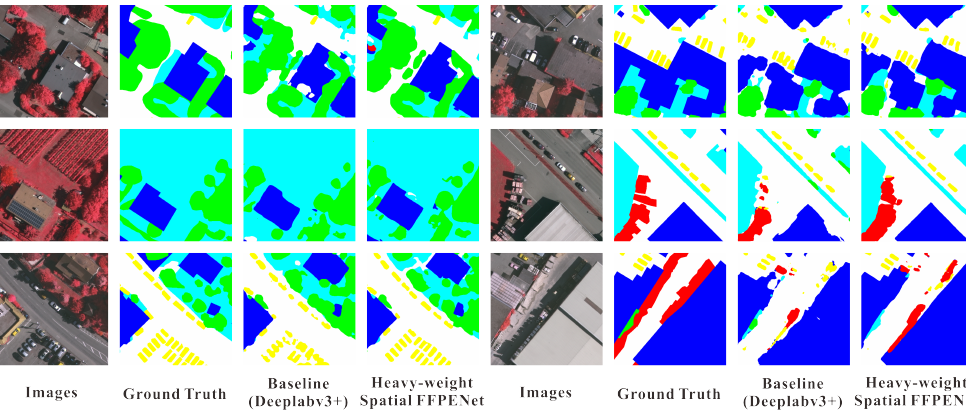
Figure 8. Qualitative comparisons between our method and the baseline (Deeplabv3+) on the Vaihingen dataset with 512 × 512 patches.